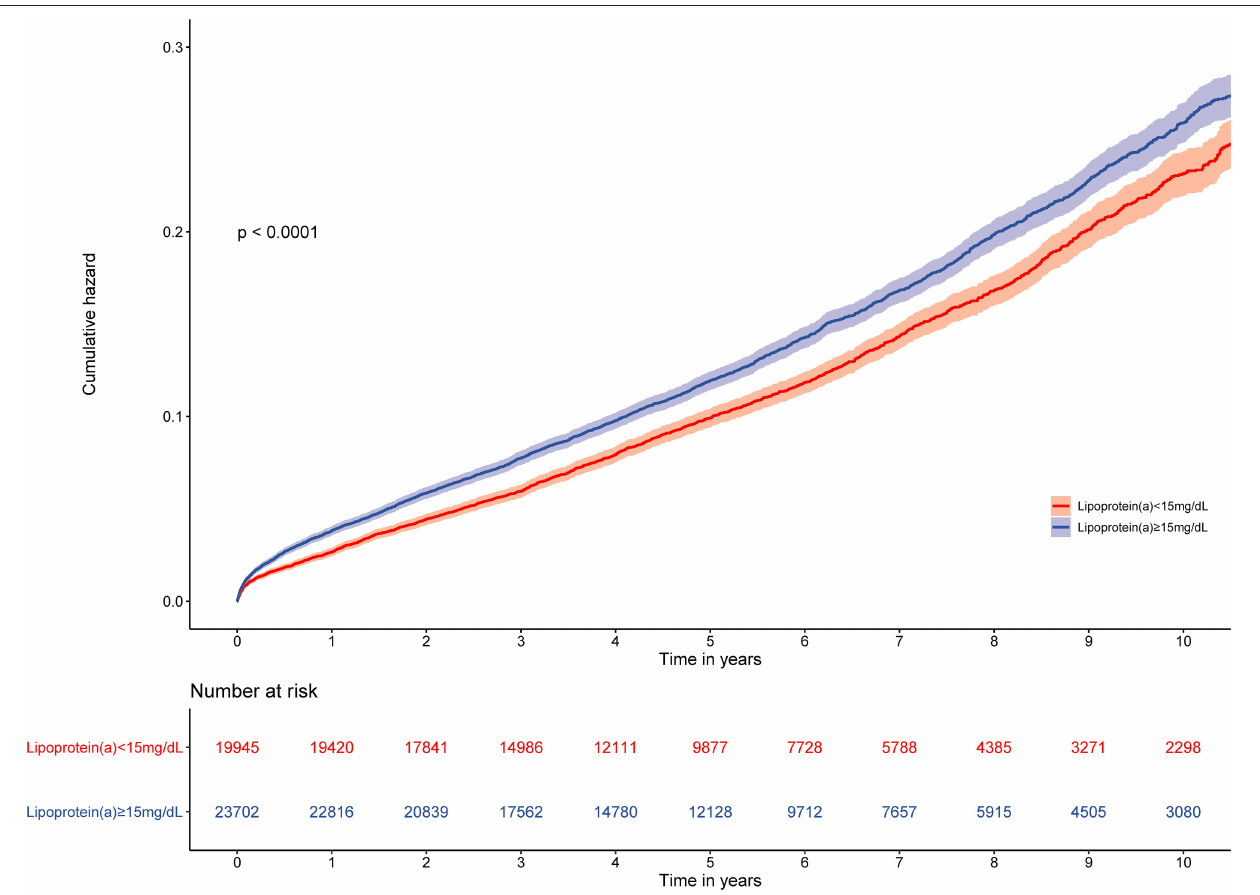
FIGURE 1 | Kaplan–Meier curves for quartile values of plasma levels of lipoprotein(a). Normal baseline lipoprotein(a) levels: < 15 mg/dL. Moderately elevated baseline lipoprotein(a) levels: ≥ 15